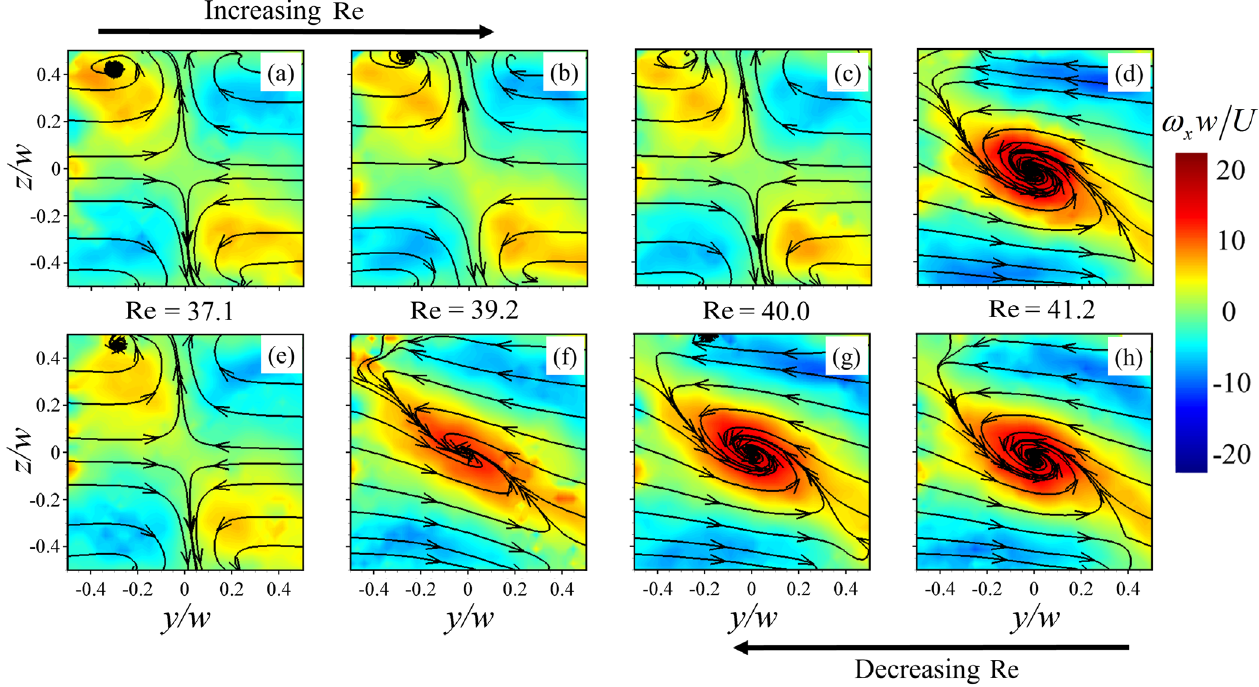
FIG. 4. Experimental μ -PIV images in the x ¼ 0 plane made using water seeded with fluorescent microparticles. Panels (a) – (d) show results for progressive increases in Re from below the transition, while panels (e) – (h) show the results for progressively decreasing Re from above the transition. (a),(e) Re ¼ 37 . 1 ; (b),(f) Re ¼ 39 . 2 ; (c),(g) Re ¼ 40 . 0 ; (d),(h) Re ¼ 41 . 2 . The color scale indicates the local value of the normalized axial